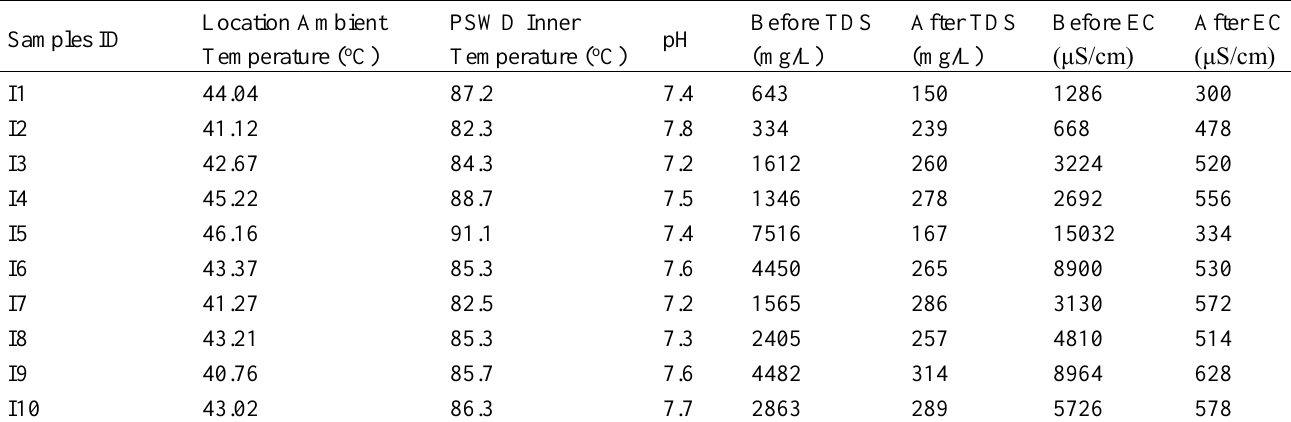
Results of Islamkot water samples before and after treatment Samples